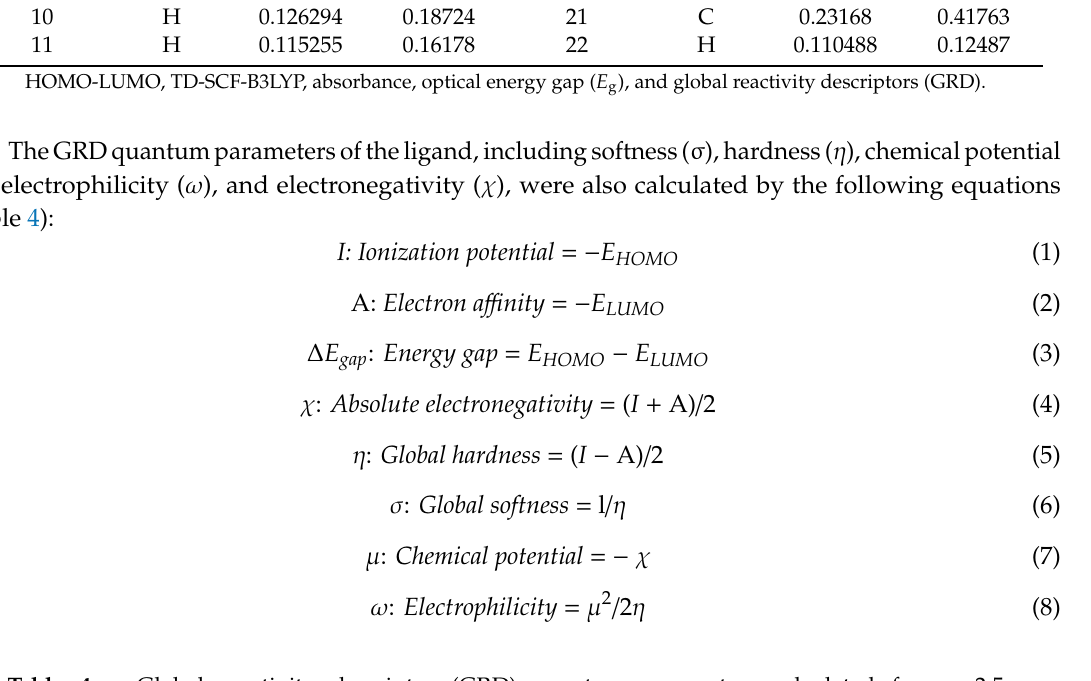
Global reactivity descriptor (GRD) quantum parameters calculated for exo -2,5-